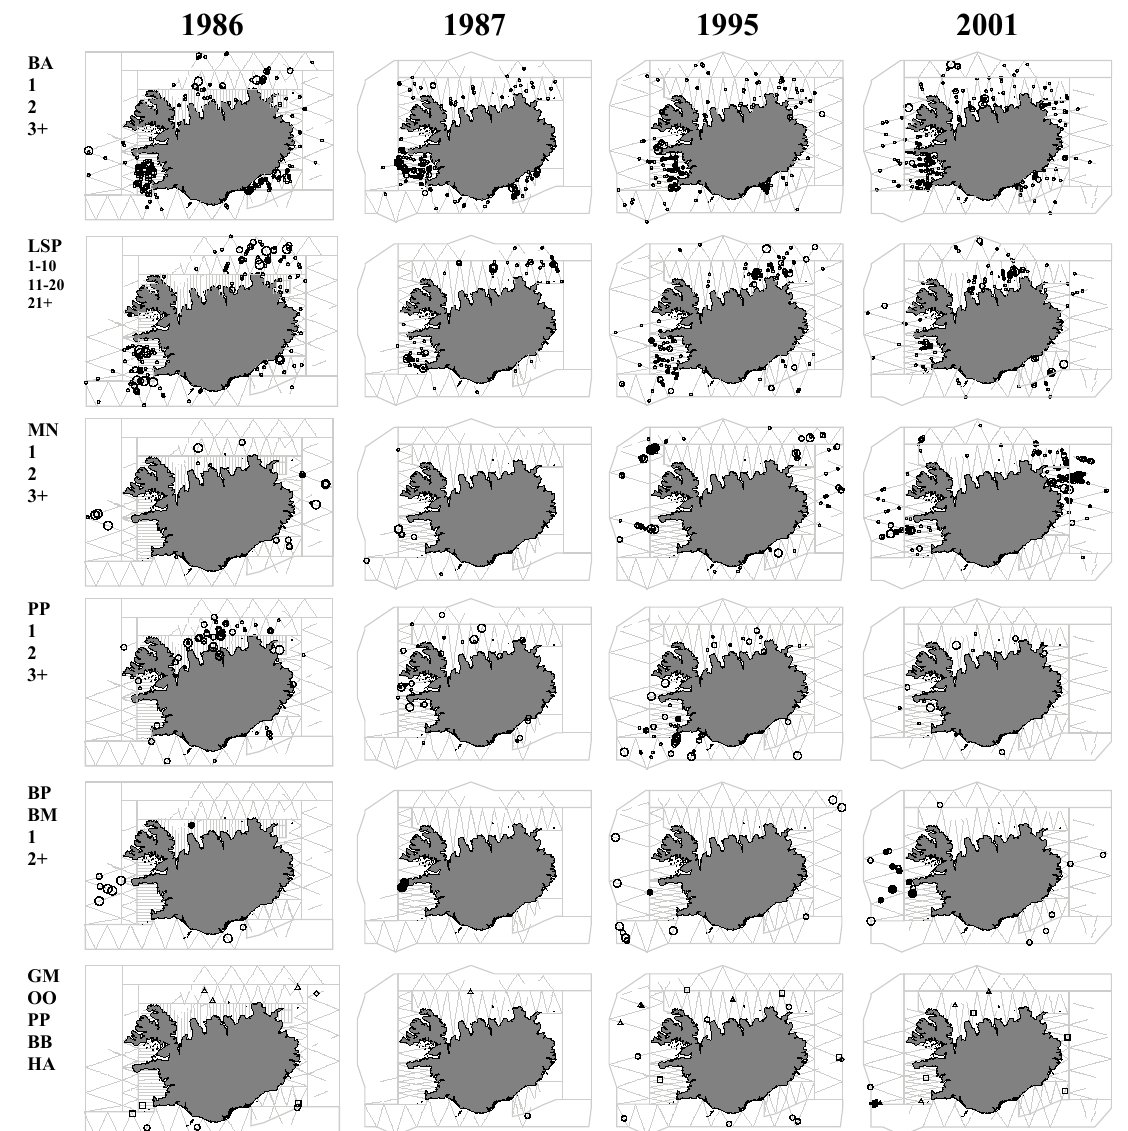
Fig. 2. Sightings of cetacean groups around Iceland during NASS aerial surveys, 1986-2001. Only on-effort sightings by the primary observers at Beaufort sea state of 4 or less are shown. The numbers on the left identify the group sizes represented by the smallest to largest symbols. Species: BA – minke whales; LSP- La - genorhynchus spp. dolphins, mainly L. albirostris; MN – humpback whale; PP – harbour porpoise; BP – fin whale; BM – blue whale (solid symbols); GM – long-finned pilot whale (circle); OO – killer whale (square); PM – sperm whale (triangle); BB – sei whale (cross); HA – northern bottlenose whale